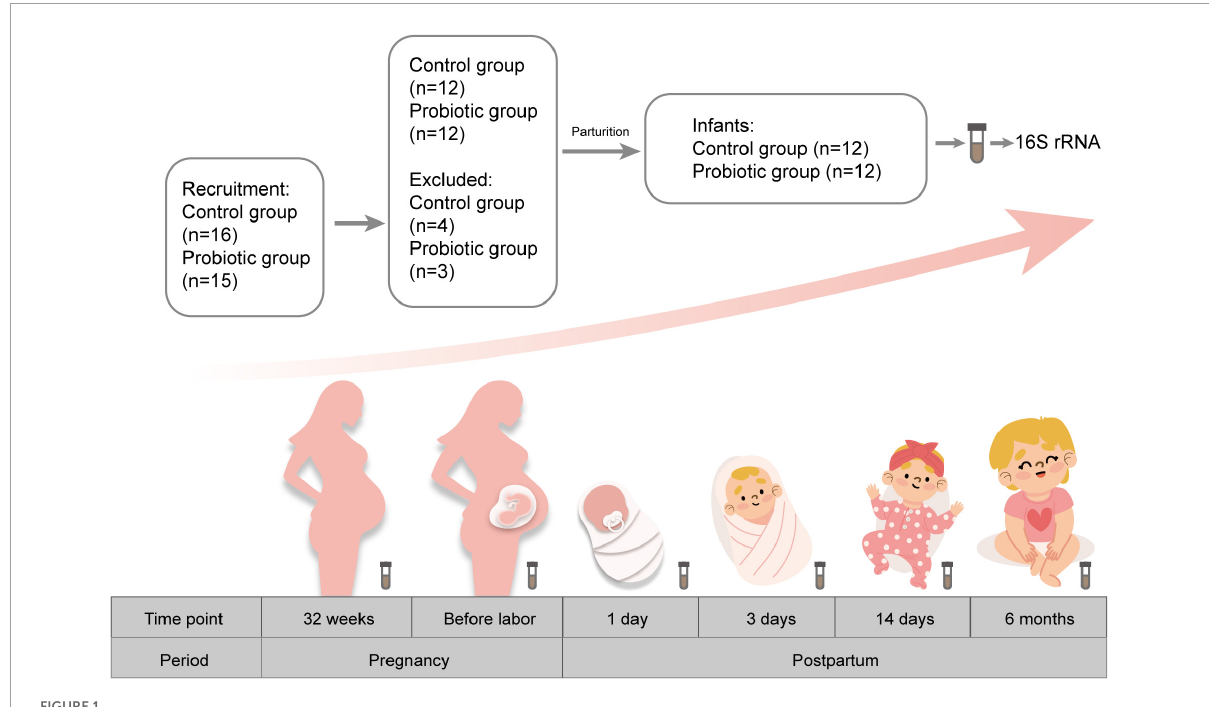
FIGURE1 Flow chart for screening